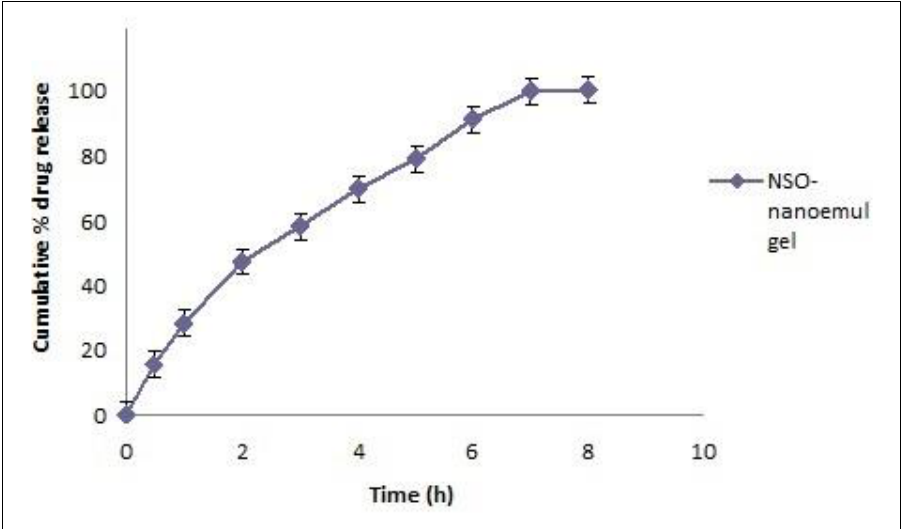
Figure 4. Drug release plot for the developed NSO nanoemulgel showing sustained drug release up to 8 h (n = 3).